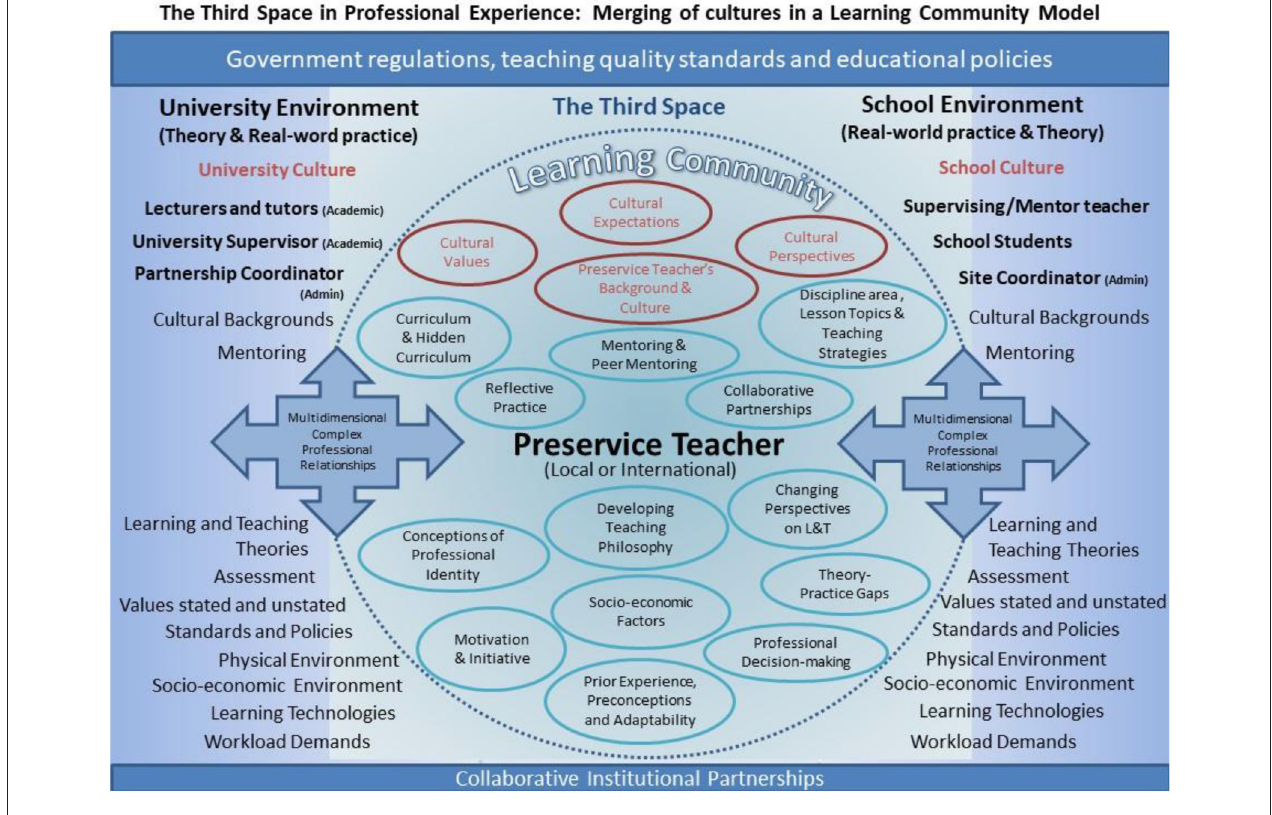
FIGURE 2 | The Third Space in Professional Experience (3PEx): merging of cultures in a learning community